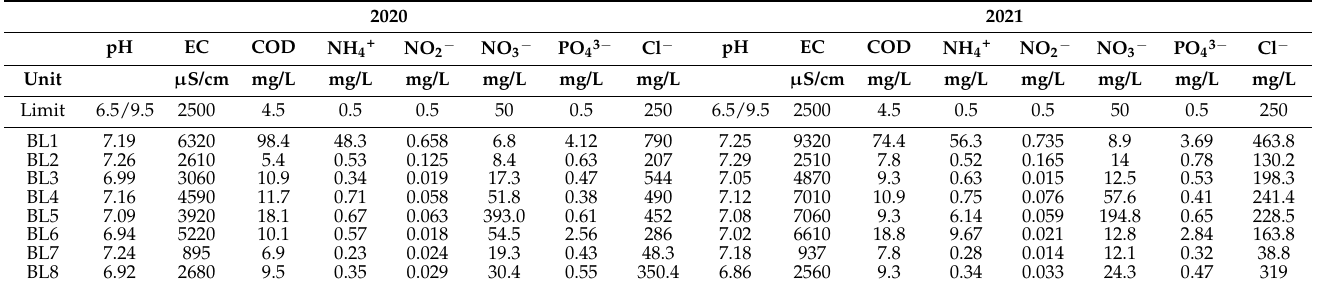
Table 2. Summary of the water quality parameters measured in the summers of 2020 and 2021.